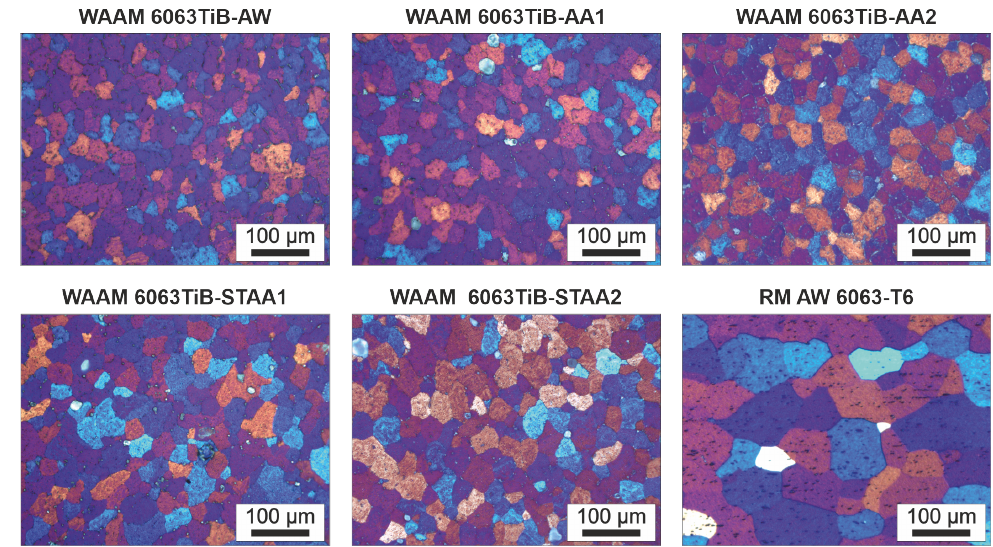
Figure 5. The microstructure and mean grain size of WAAM samples for different PWHT conditions in comparison to the wrought base material AW